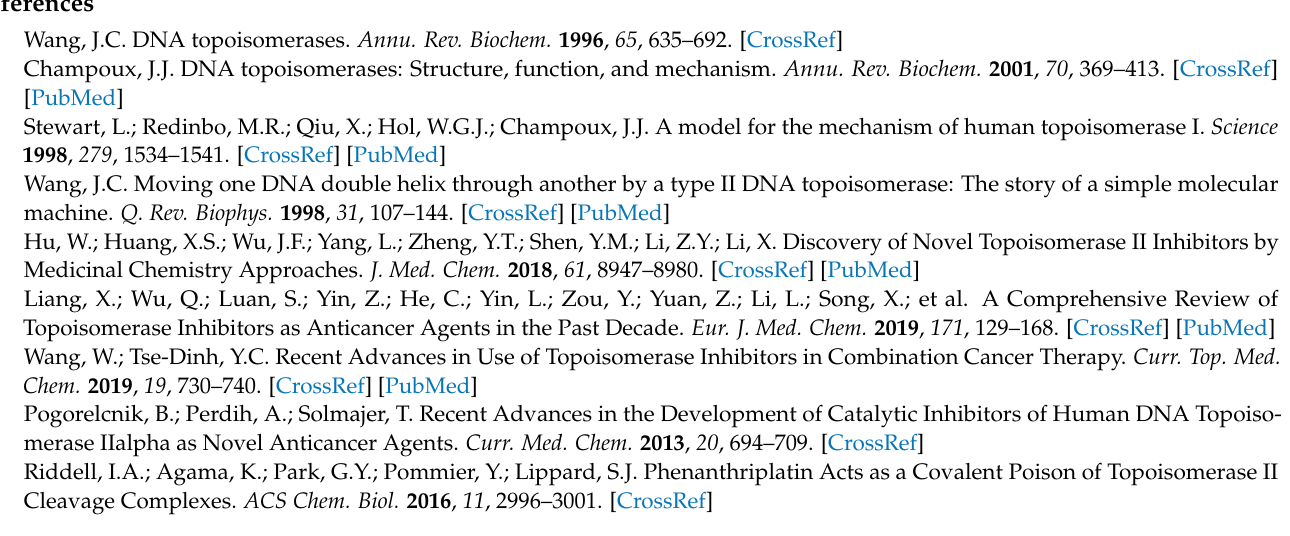
of compound 4e , Figure S54: 13 C-NMR (101 MHz, CDCl 3 ) spectrum of compound 4e , Figure S55: IR (KBr) spectrum of compound 4e , Figure S56: Mass spectrum of compound 4e , Figure S57: 1 H-NMR (200 MHz, CDCl 3 ) spectrum of compound 5a , Figure S58: 13 C-NMR (101 MHz, CDCl 3 ) spectrum of compound 5a , Figure S59: IR (KBr) spectrum of compound 5a , Figure S60: 1 H-NMR (200 MHz, CDCl 3 ) spectrum of compound 5b , Figure S61: 13 C-NMR (101 MHz, CDCl 3 ) spectrum of compound 5b , Figure S62: IR (KBr) spectrum of compound 5b , Figure S63: 1 H-NMR (200 MHz, CDCl 3 ) spectrum of compound 5c , Figure S64: 13 C-NMR (101 MHz, CDCl 3 ) spectrum of compound 5c , Figure S65: IR (KBr) spectrum of compound 5c , Figure S66: 1 H-NMR (200 MHz, CDCl 3 ) spectrum of compound 5d , Figure S67: 13 C-NMR (101 MHz, CDCl 3 ) spectrum of compound 5d , Figure S68: IR (KBr) spectrum of compound 5d , Figure S69: Mass spectrum of compound 5d , Figure S70: 1 H-NMR (200 MHz, CDCl 3 ) spectrum of compound 5e , S71: 13 C-NMR (101 MHz, CDCl 3 ) spectrum of compound 5e , Figure S72: IR (KBr) spectrum of compound 5e , Figure S73: 1 H-NMR (200 MHz, CDCl 3 ) spectrum of compound 6a , Figure S74: 13 C-NMR (101 MHz, CDCl 3 ) spectrum of compound 6a , Figure S75: IR (KBr) spectrum of compound 6a , Figure S76: 1 H-NMR (200 MHz, CDCl 3 ) spectrum of compound 6b , Figure S77: 13 C-NMR (101 MHz, CDCl 3 ) spectrum of compound 6b , Figure S78: IR (KBr) spectrum of compound 6b , Figure S79: 1 H-NMR (200 MHz, CDCl 3 ) spectrum of compound 6c , Figure S80: 13 C-NMR (101 MHz, CDCl 3 ) spectrum of compound 6c , Figure S81: IR (KBr) spectrum of compound 6c , Figure S82: Mass spectrum of compound 6c , Figure S83: 1 H-NMR (200 MHz, CDCl 3 ) spectrum of compound 6d , Figure S84: 13 C-NMR (101 MHz, CDCl 3 ) spectrum of compound 6d , Figure S85: IR (KBr) spectrum of compound 6d , Figure S86: 1 H-NMR (200 MHz, CDCl 3 ) spectrum of compound 6e , Figure S87: 13 C-NMR (101 MHz, CDCl 3 ) spectrum of compound 6e , Figure S88. IR (KBr) spectrum of compound 6e